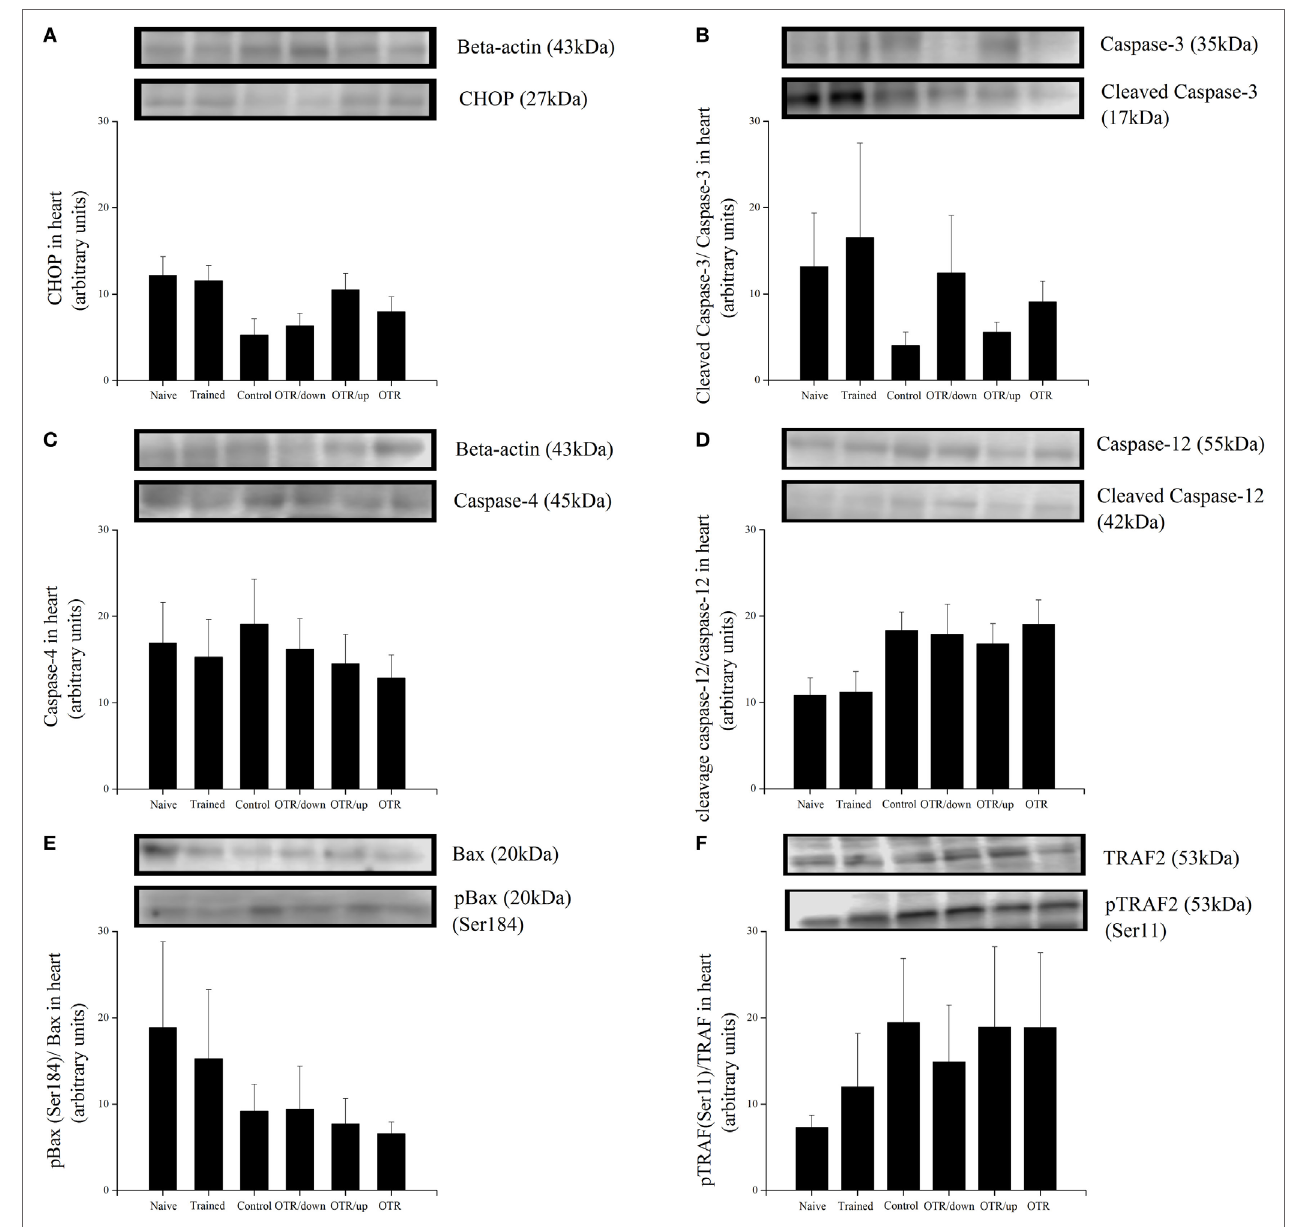
FigUre 5 | Protein levels (arbitrary units) of C/EBP-homologous protein (CHOP) (a) , Cleaved Caspase-3/Caspase-3 (b) , Caspase-4 (c) , Cleaved Caspase-12/ Caspase-12 (D) , pBax (Ser184)/Bax (e) , and pTRAF2 (Ser11)/tumor necrosis factor receptor-associated factor 2 (TRAF2) (F) in the hearts of experimental animals. Data are expressed as the mean ± SE of n = 8 mice. N, sedentary mice; TR, trained mice; CT, sedentary mice; OTR/down, overtrained by downhill running; OTR/ up, overtrained by uphill running; OTR, overtrained by running without inclination. The original experiments are available in supplementary file 10 (i.e., Caspase-4, Caspase-12 and Caspase-12), files 12a.b and 12c.d (i.e., Cleaved Caspase-3, Caspase-3, pBax and BAX), file 13 (i.e., TRAF2), file 14 (i.e., pTRAF2), and file 15 (i.e.,